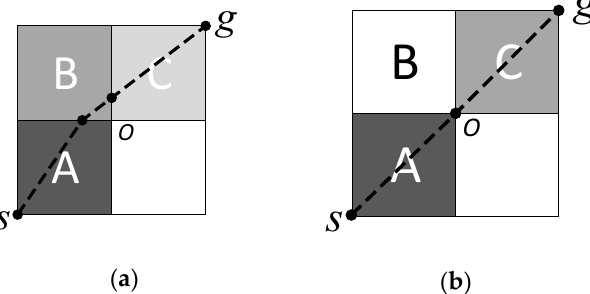
Figure 4. The ABC and AC are both channels from s to g . ( a ) 4-connectivity model; ( b ) 8-connectivity model.